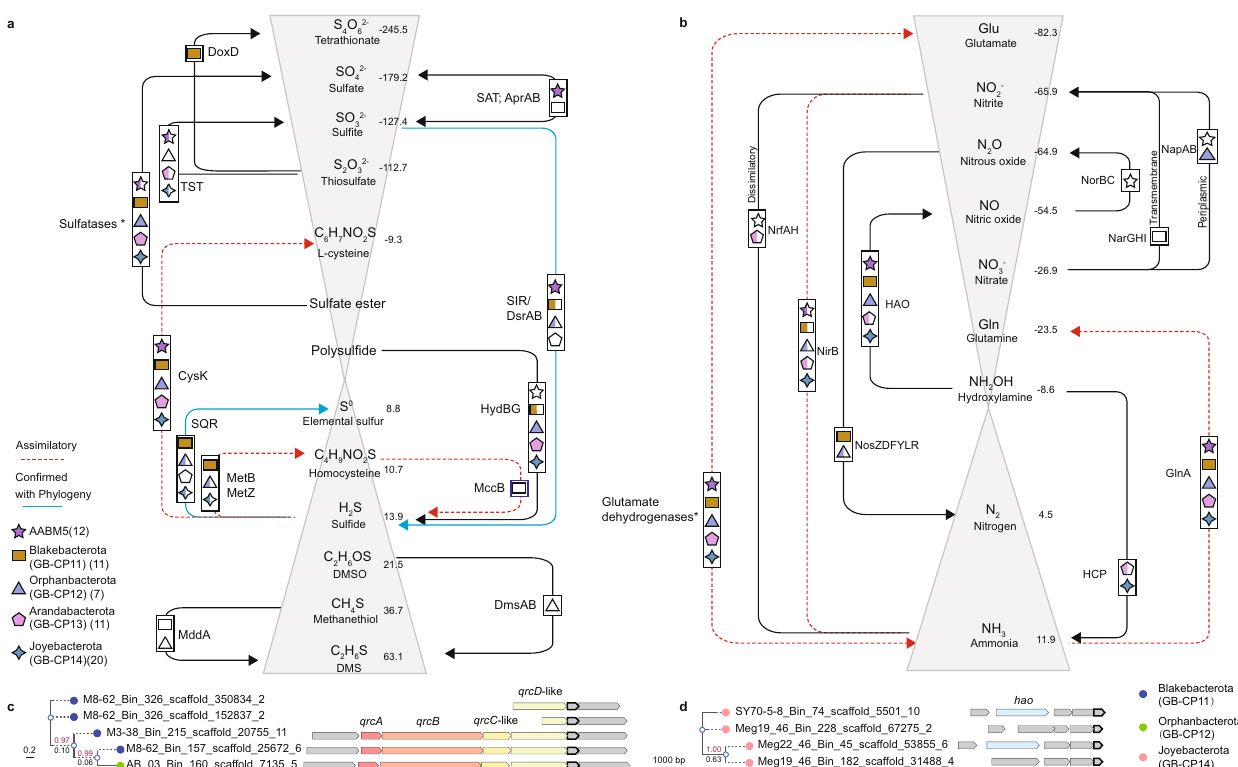
Fig. 4 | Genomic-basedpredictionsofthe potential metabolicroleofthenovel bacterialphyla. Keystepsinthe ( a )sulfur and ( b ) nitrogen cyclespredicted inthe fi ve bacterialphyla.Compounds(in graytriangleframes) werearranged according to the standard Gibbs free energy of formation of each sulfur or nitrogen com- pound (values next to the compound taken from Caspi et al. 93 ). Star, square, tri- angle, pentagon, and diamond shapes correspond to AABM5, Blakebacterota, Orphanbacterota, Arandabacterota and Joyebacterota, respectively. Colored shapes represent the presence of genes in a given pathway. Fully colored shapes indicatethepresenceofgenesinover50%ofthephyla.Halfcoloredshapessignify